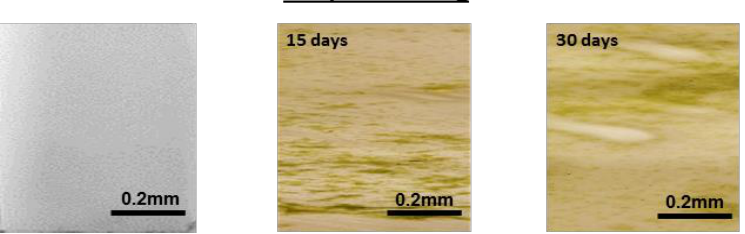
Figure 6. Qualitative antifouling test image of the PVA/GA coating surfaces observed at immersion times of 15 days and 30 days.